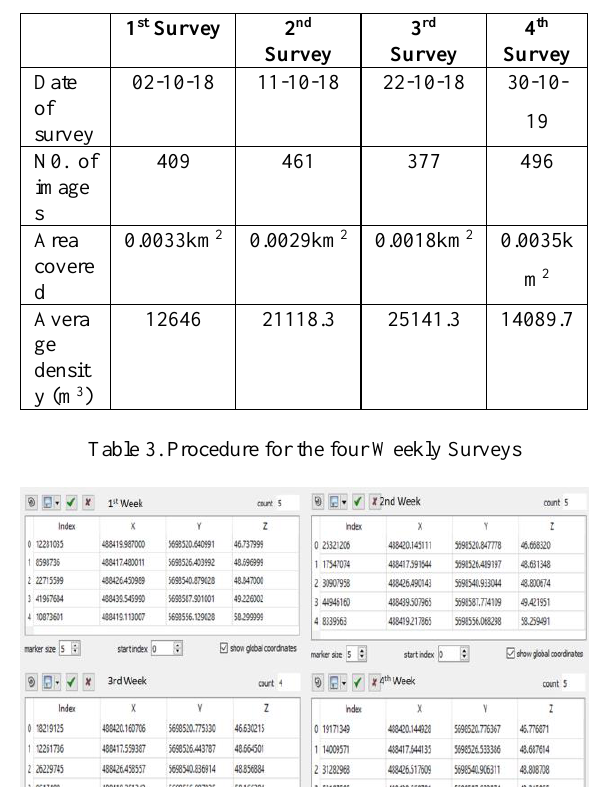
Figure 9. Dense Point Clouds from four Weekly Surveys